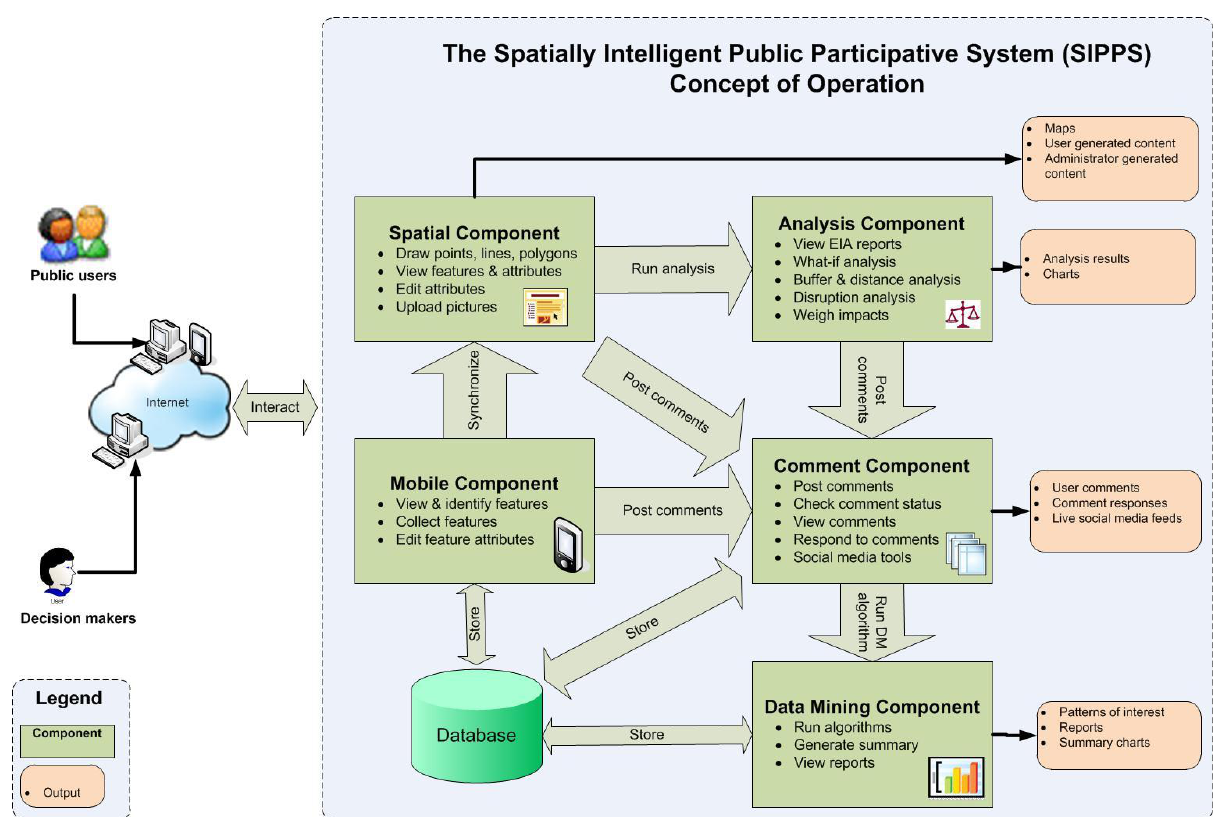
Figure 1. Conceptual framework for